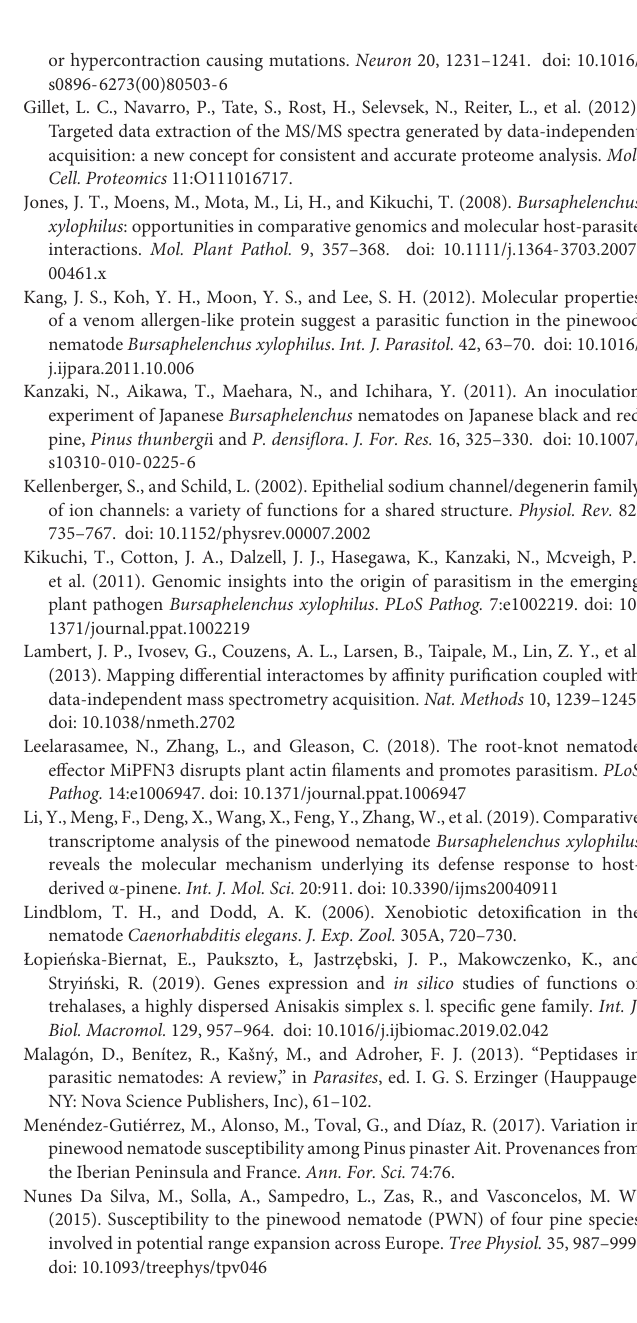
Supplementary Table 2 | Secretome analysis by SWATH-MS. Statistical analysis was performed by Mann–Whitney U test and statistical significance was considered for q-values < 0.05. Pairwise comparisons were performed using the normalized protein levels subjected to Log10 transformation. The levels of the proteins were estimated by summing all the filtered transitions from all the filtered peptides for a given protein and normalized to the total intensity within the same experimental